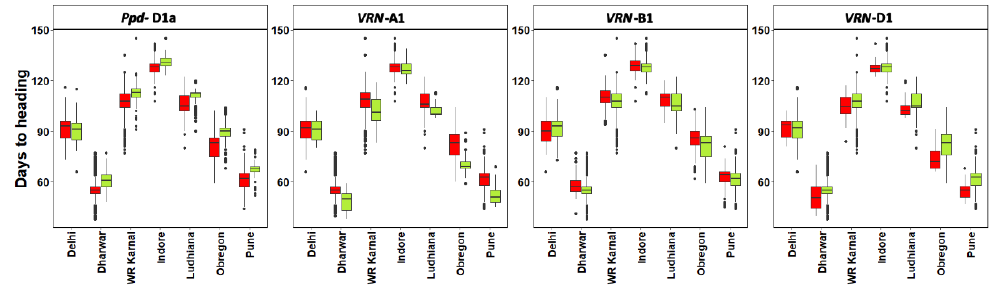
Figure 3. Effect of known Ppd and Vrn genes on the heading days. The horizontal bar in the box is